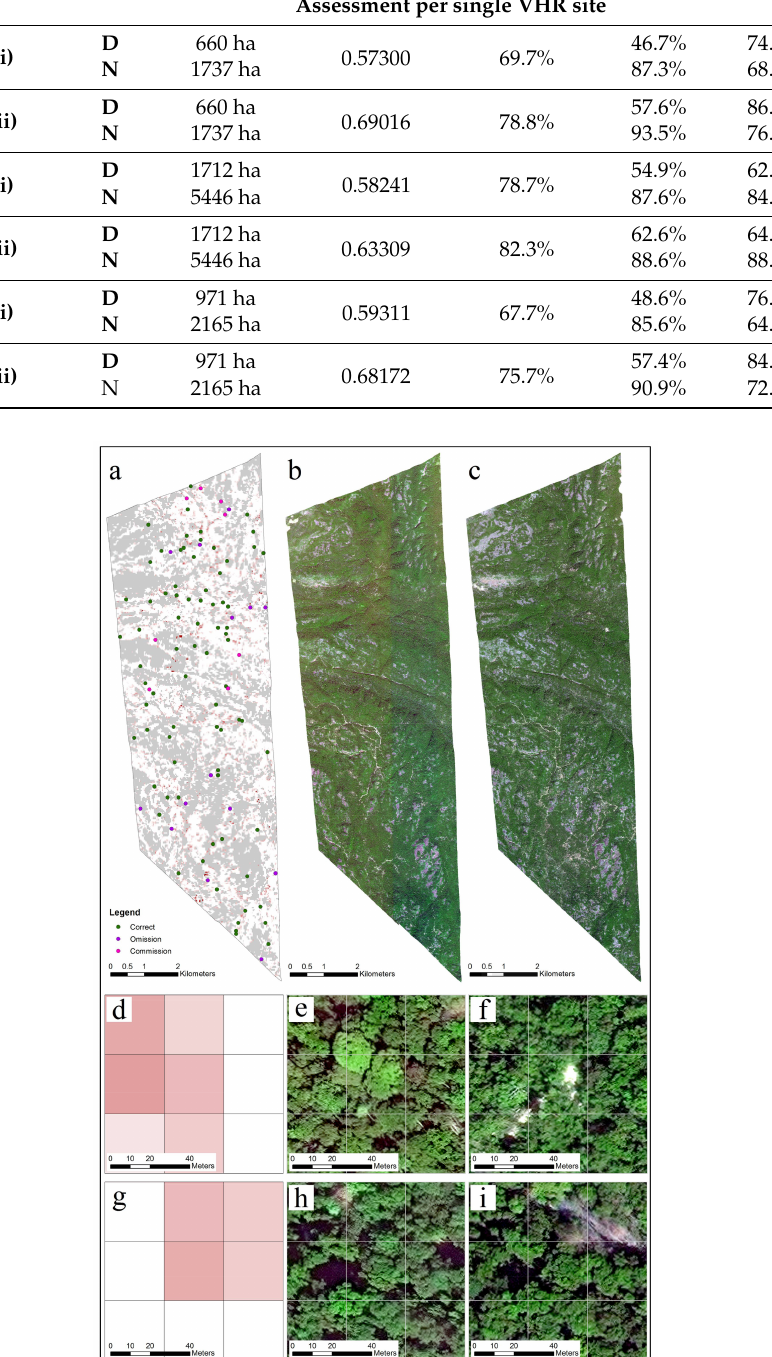
Figure 5. Accuracy assessment sampling design for test site 4 in Laos (Attapeu province). ( a ) Evergreen forest (status end 2016) = white; possible disturbance events = reddish; threshold = 0.02; other land cover types = grey. Attributes of sampling points validated with corresponding VHR WorldView-2 ( b ) and GeoEye-1 ( c ) reference scenes; green = correct result; violet = error of omission; pink = error of commission. ( d – f ) Subset of actual canopy disturbance. ( g – i ): Subset of seasonal crown cover change. ( d , g ) ∆ rNBR. ( e , h ) VHR from 2 January 2015. ( f , i ) VHR from 14 February